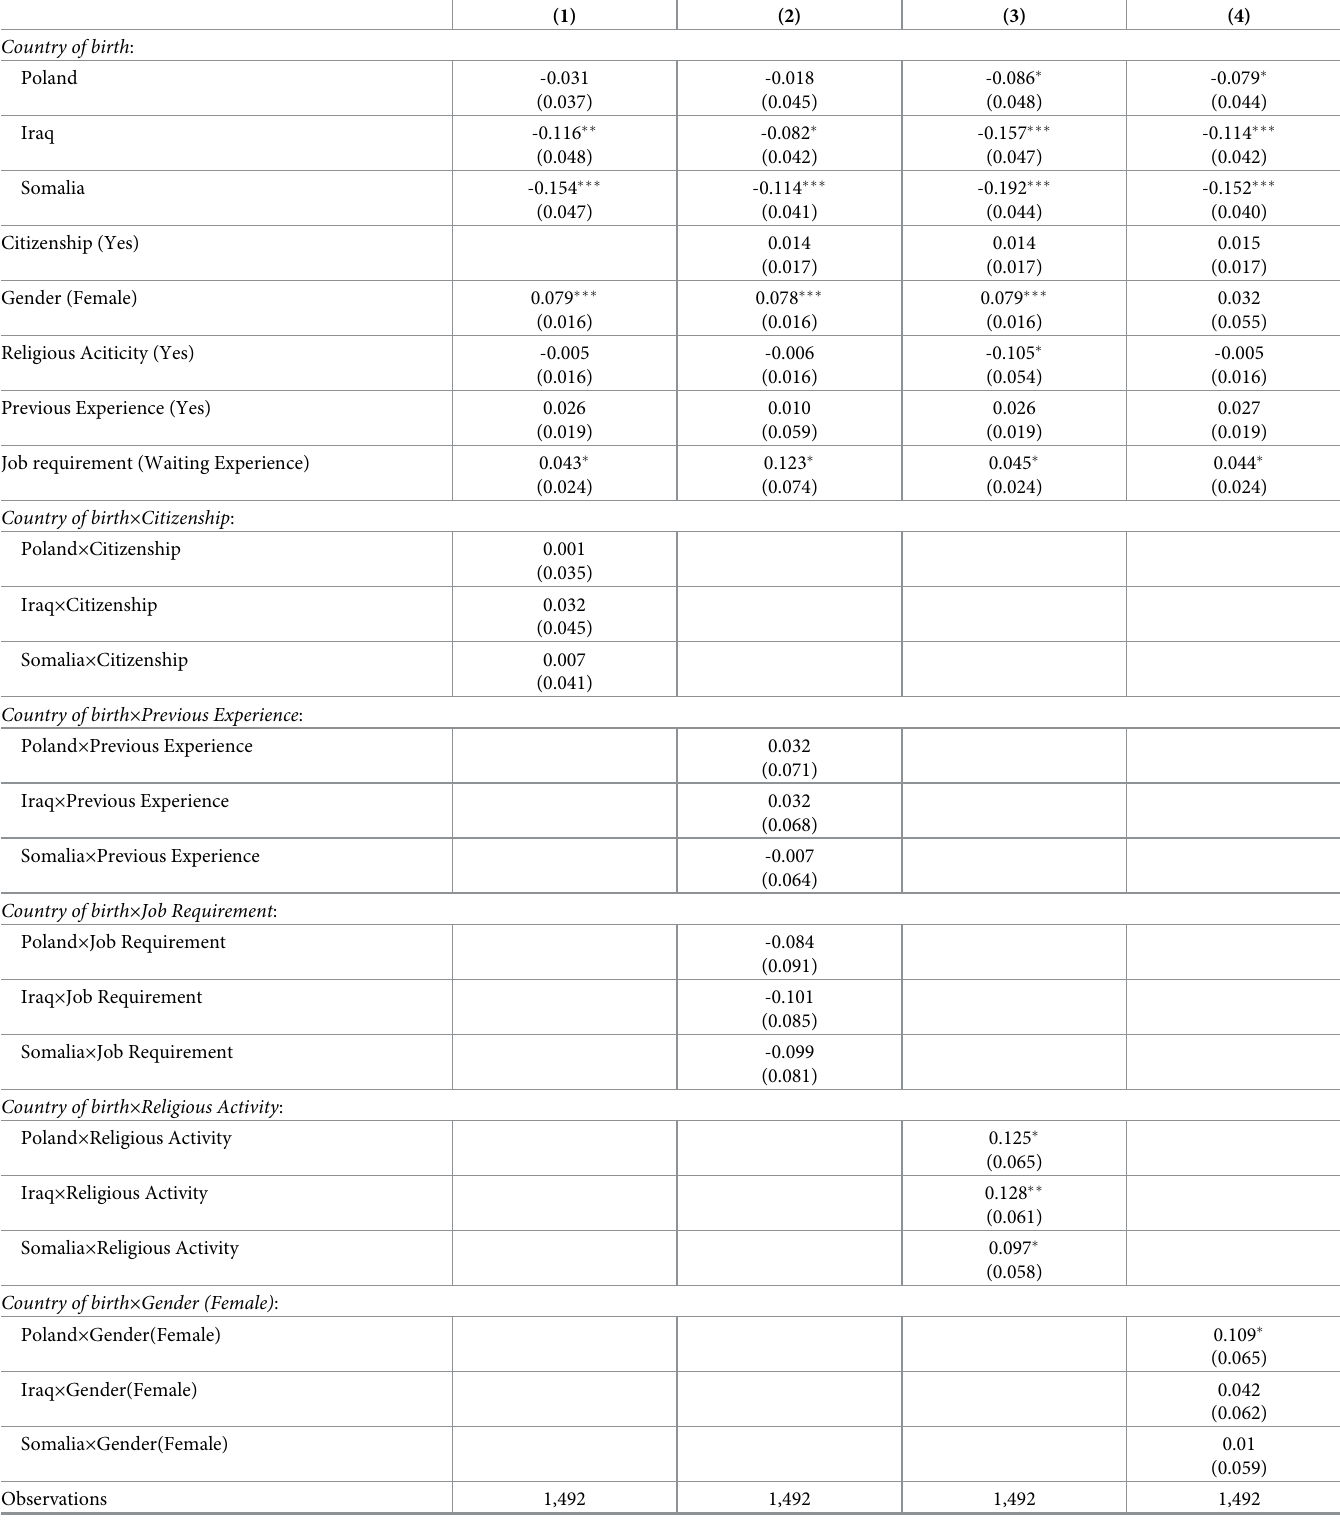
Table 4. Heterogeneous effects of country of birth. DV: Employer